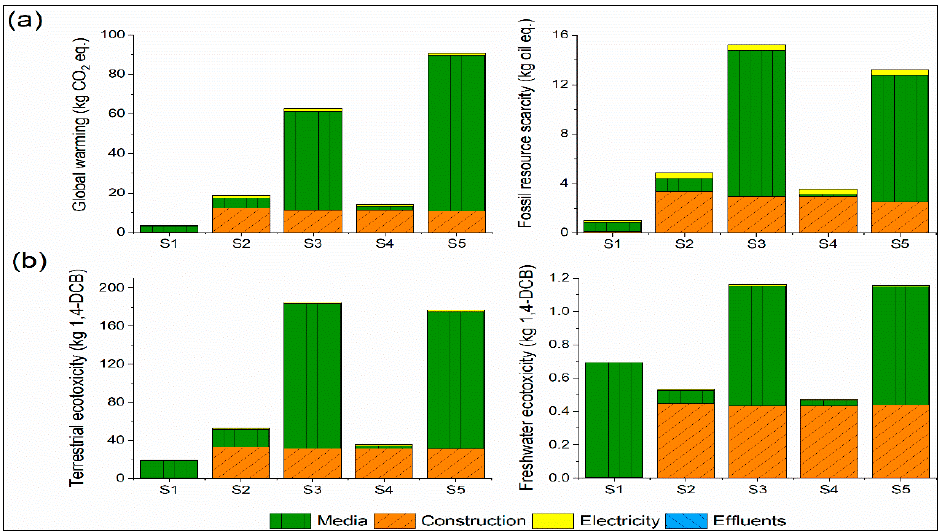
Figure 3. Impact on ( a ) global warming, fossil resource scarcity, and ( b ) terrestrial, freshwater ecotoxicity categories, during the overall life cycle of CWs.